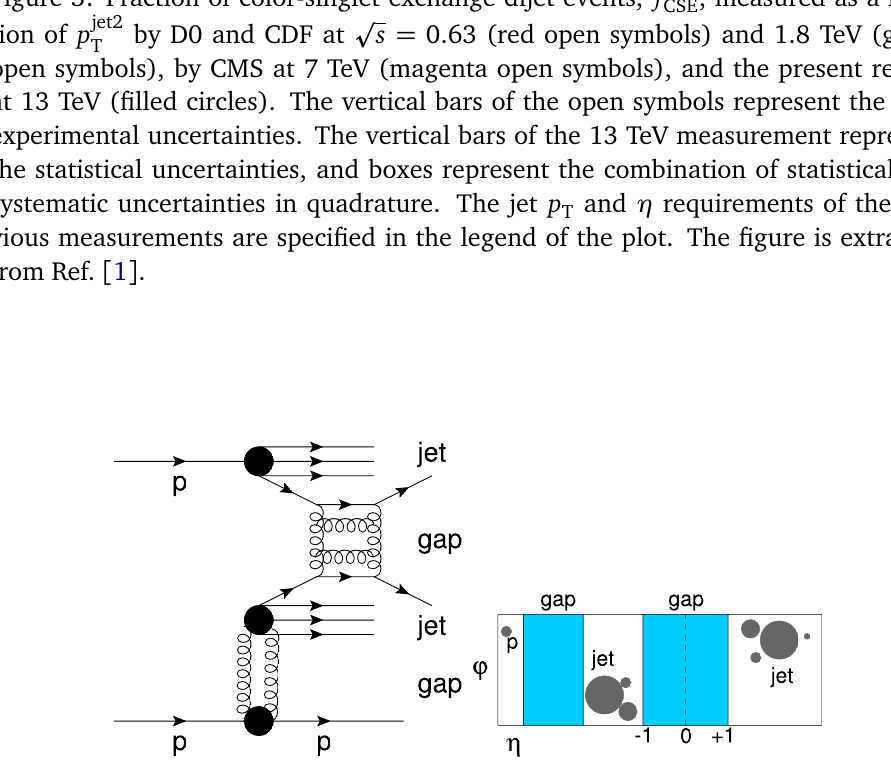
Figure 4: (Left) Schematic diagram of a jet-gap-jet event by hard color-singlet ex- change with an intact proton in pp collisions. (Right) Signature in the η - φ plane. The filled circles represent final-state particles. The shaded rectangular areas denote the central gap region | η | < 1 devoid of charged particles and the forward gap that is inferred from the intact proton. The figure is extracted from Ref. [ 1 ]